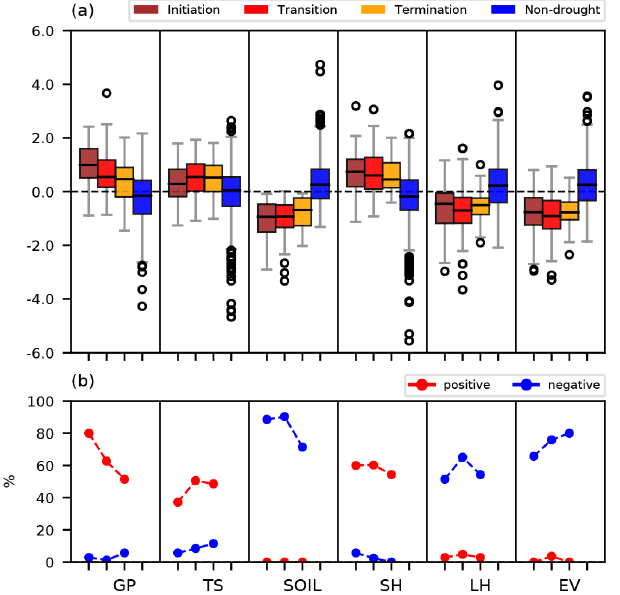
Figure 13. Time series of annual soil moisture (SOIL) and precip- itation anomalies from 1850 to 2099CE with respect to the 1000– 1849CE means. Brown lines indicate a 10-year running means, and dashed lines indicate the detrended time series. The values of the removed trends are presented in Fig.